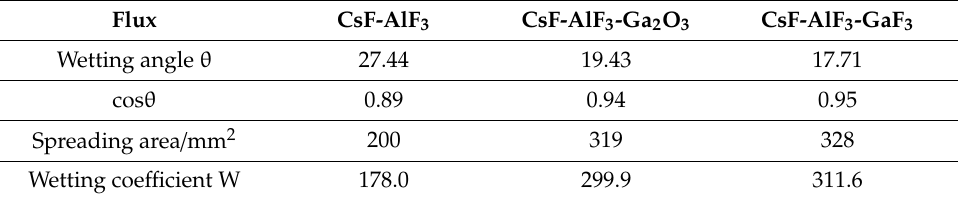
Table 3. Wetting angles of di ff erent fluxes.